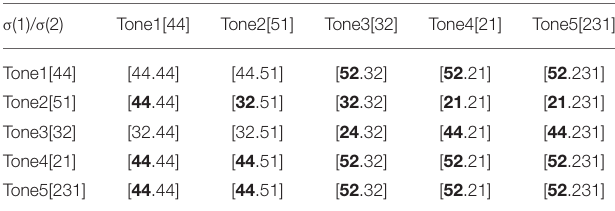
The dot “.” stands for syllable break, and numbers in bold indicate sandhi